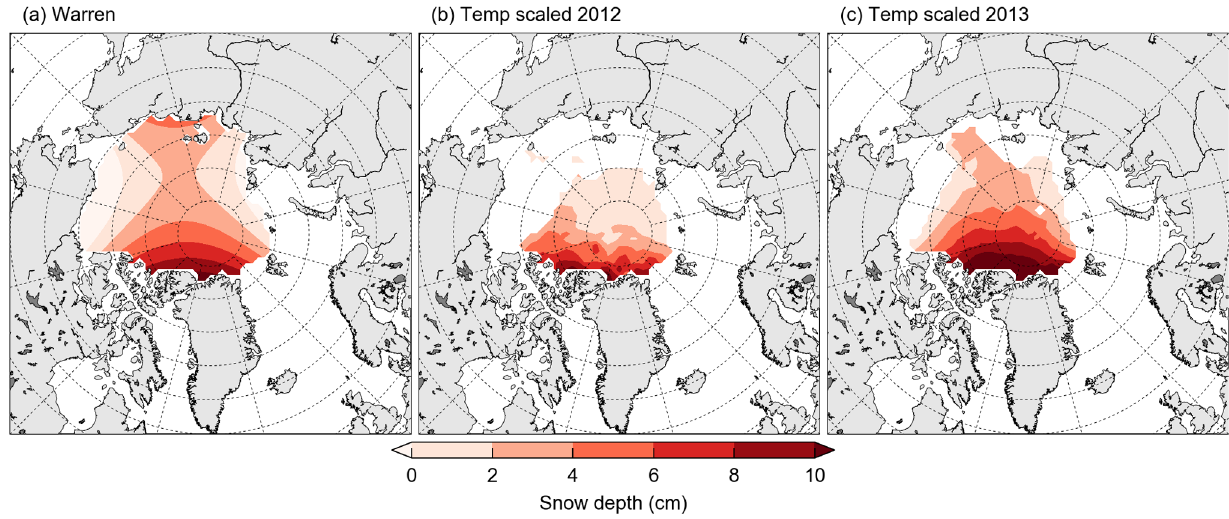
Figure 2. (a) Warren climatology of August snow depth, (b, c) the initial conditions used in this study (broadly representing the snow depth as of 15 August) for 2012 and 2013, respectively, calculated using near-surface air temperature